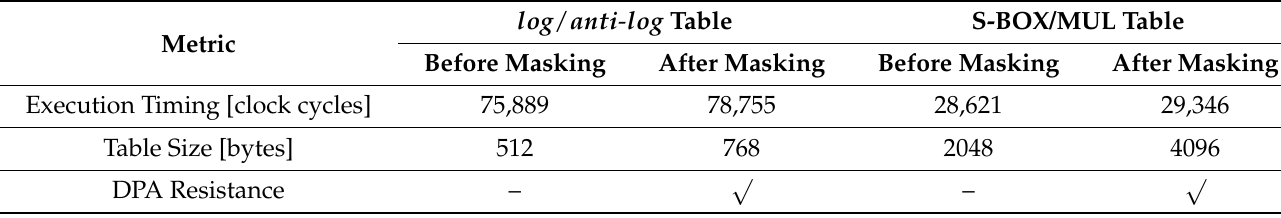
Table 3. Performance comparison result on the AVR microcontroller.